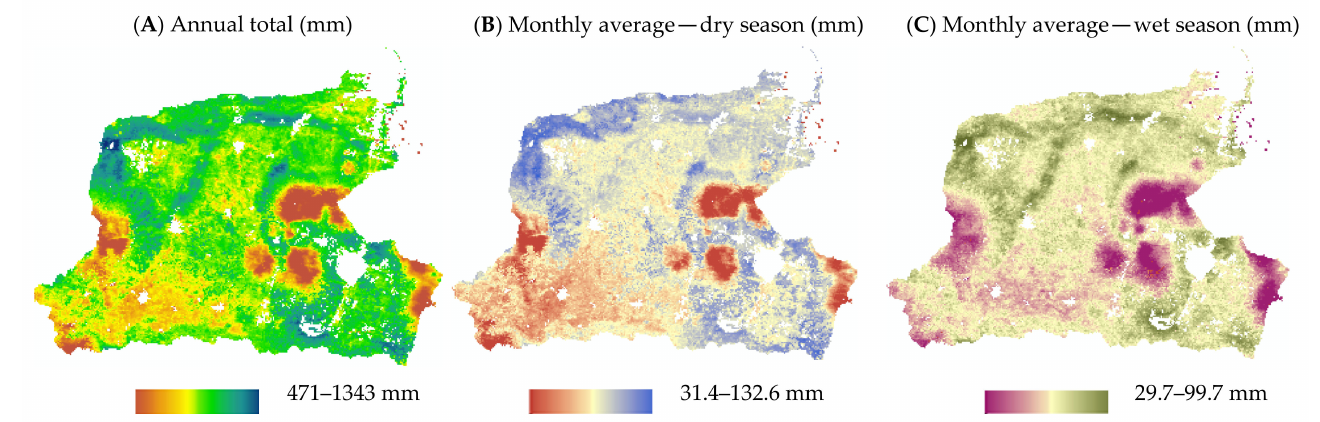
Figure 7. Spatial patterns of long-term PET at three different temporal scales: long-term average of total annual PET ( A ), long-term monthly average of dry season ( B ), and long-term monthly average of dry season ( C ), from 2001 to 2020.